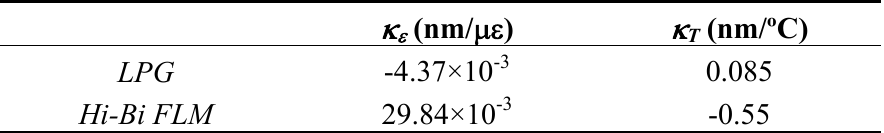
Table 4. Strain and temperature coefficients of the Hi-Bi PCF fiber loop mirror and LPG spectral